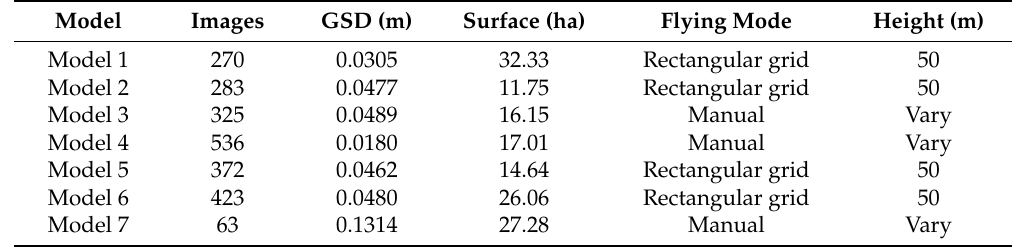
Figure 5. Flying modes implemented for mapping mining sites presented in this work. ( a ) Automatic flying mode and a single flying line: Model 1; ( b ) Manual flight: Model 3, 4 and 7; ( c ) automatic grid and double flying line: Models 2, 5 and 6. Red dots locate the image photocenters and black lines represent the image marks. Table 1. Modeling conditions and principal flight